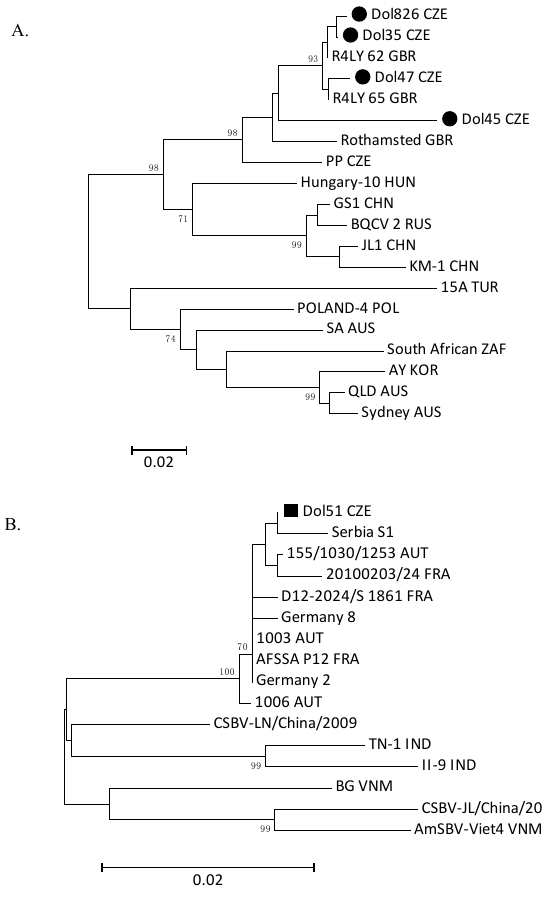
Figure 2. ( A ) Phylogenetic tree based on BQCV partial helicase gene sequences (between nt positions 2679 and 2961 referring to the complete genome sequence KY243932). The Czech BQCV strains described in this study are marked with a black dot ( ● ). ( B ) Phylogenetic tree based on partial SBV polyprotein gene sequences (between nt 240 and 668 referring to the complete genome sequence HM237361). The Czech SBV strain from this study is marked with a black square ( ■ ). The evolutionary distances in both trees are in the units of the number of base substitutions per site. The trees were generated with the neighbour-joining method using MEGA version 7. Bootstrap values (1000 replicates) below 70% were hidden.